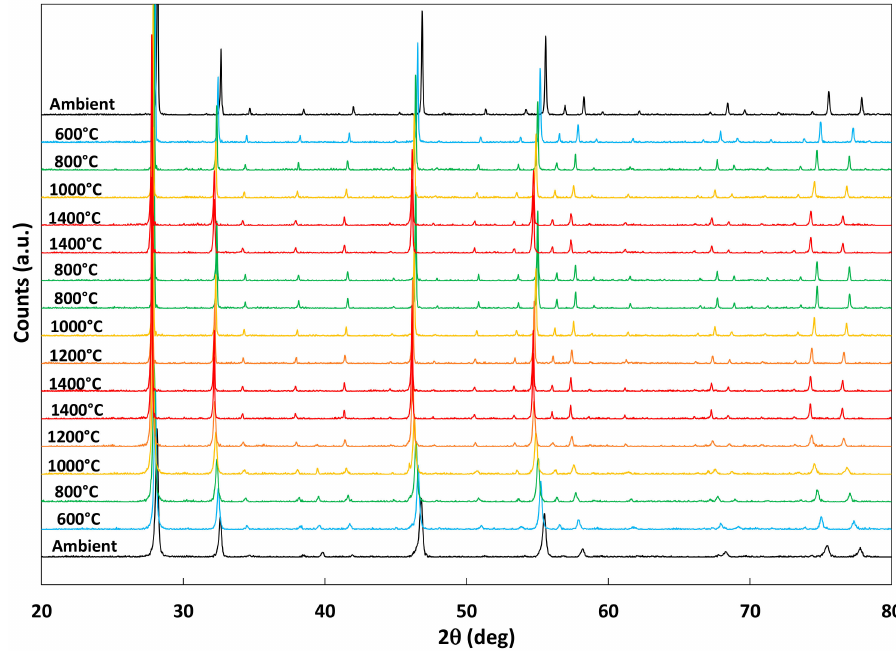
Figure 8. In situ XRD analysis of HEO 3 during two consecutive thermochemical cycles. 2.3. Perovskites-Based HEO (Related to HEO 4, HEO 5 and HEO 6) HEO 4, HEO 5 and HEO 6 are perovskite-structured materials related to high entropy oxides. The desired chemical compositions are, respectively, (Gd 0.2 La 0.2 Nd 0.2 Sm 0.2 Y 0.2 ) (Co 0.2 Cr 0.2 Fe 0.2 Mn 0.2 Ni 0.2 )O 3 , (La 0.5 Sr 0.5 )(Mn 0.2 Ce 0.2 Ni 0.2 Mg 0.2 Cr 0.2 )O 3 and (La 0.8 Sr 0.2 ) (Mn 0.2 Fe 0.2 Co 0.4 Al 0.2 )O 3- δ . XRD analyses of the compounds are shown in Figure 9 af- ter different heat treatments and after thermochemical cycling.